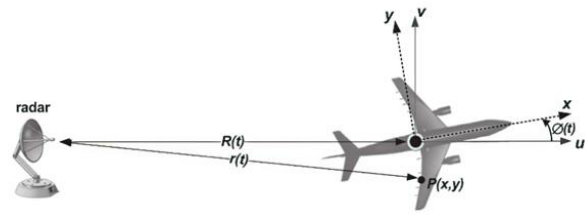
Figure 2. Geometry for a moving target with respect to radar.